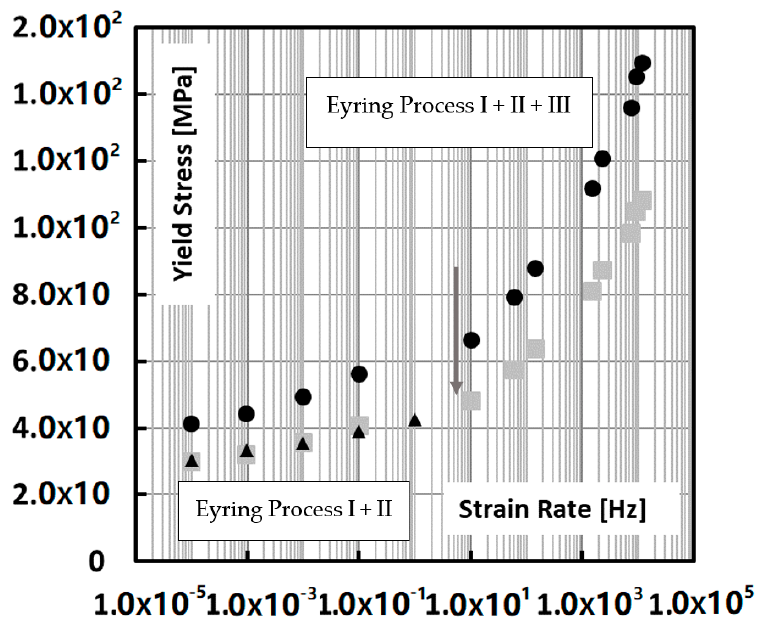
Figure 10. Strain rate dependence of the yield stress of isotactic PP. The black dots represent the compression measurements by Okereke et al. [34], the large grey squares is the same data set corrected for tensile axial load and friction, based on data measured by Van Erp et al. [35] which are plotted in black triangles. The grey arrow indicates the assumed onset of T g . Also the Eyring processes mentioned in the text are indicated.